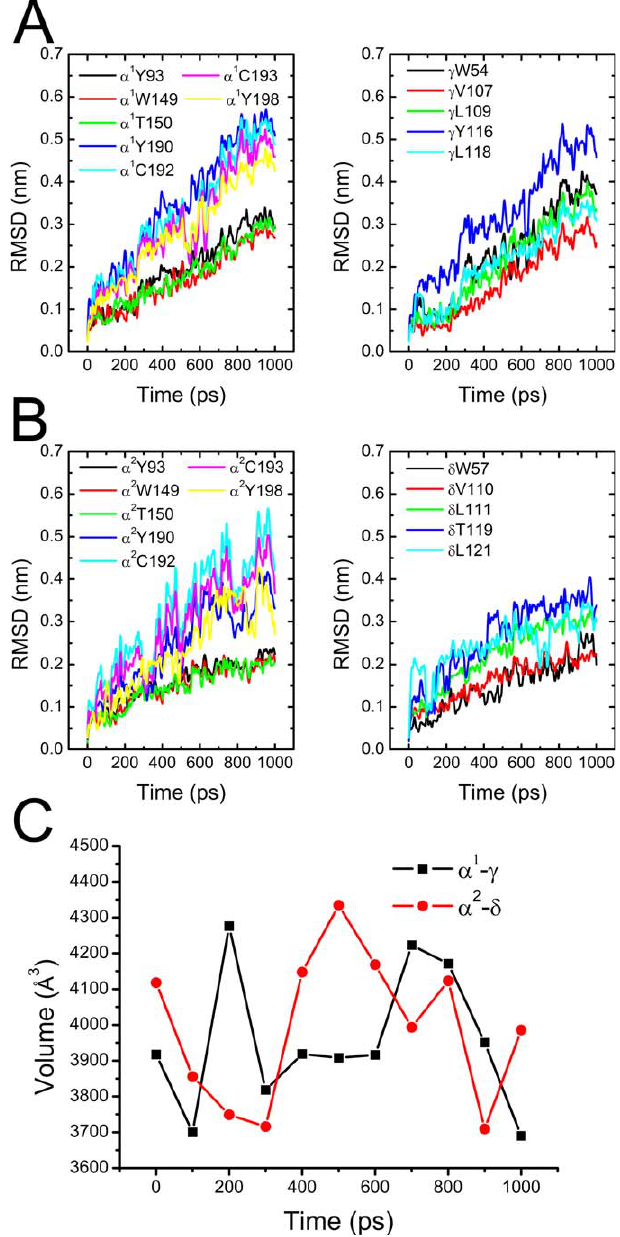
Figure 9. Dynamics of the ACh Binding Pockets Revealed by the SRMD Simulation (A–B) The time-dependence of RMSD values of the conserved residues consisting of type-I and type-II binding pockets, respectively. (C) The time-dependence of volumes of the binding pockets. Black and red curves represent type-I ( a 1 - c ) and type-II ( a 2 - d ) pockets, respectively. (Figure 9A and 9B). Unlike the results of CMD simulation (Figure 2A), the two binding pockets fluctuate along the SRMD trajectory, as shown in Figure 9C.